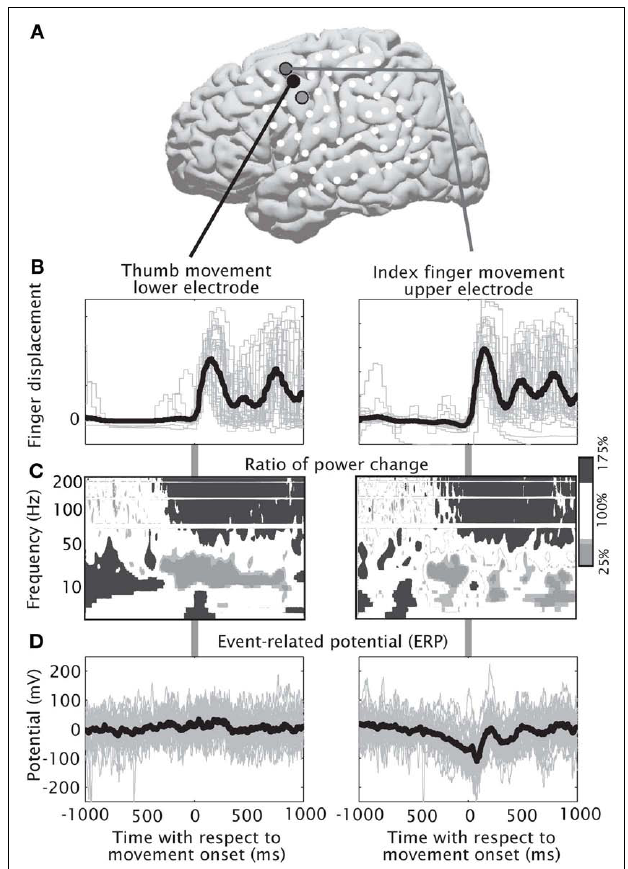
FIGURE 25 | (Data Set 4 – event-related potential). Illustration that the characteristic changes in the power spectral density changes with activity are not due to an reproducible event-related potential shift (ERP).Two adjacent electrodes are shown in (A) . One has an ERP, and one does not, but both have the characteristic peri-movement spectral changes. (B) Individual (gray) and averaged thumb movement (black, left) or index finger movement (black, right), locked to the first movement from the appropriate movement cue. (C) The normalized power spectral density (“PSD”) as a function of time. It demonstrates the classic spectral changes just prior to movement onset for both thumb and index finger. Note that the decrease in power at lower frequencies ( α / β / µ range), and the increase in power at higher frequencies (above about 40Hz) both begin before movement onset. (D) Individual and averaged raw potential traces around each of the first movements from appropriate thumb or index finger movement epochs. There is no significant event-related potential (ERP) effect for thumb, but there is for the index finger.